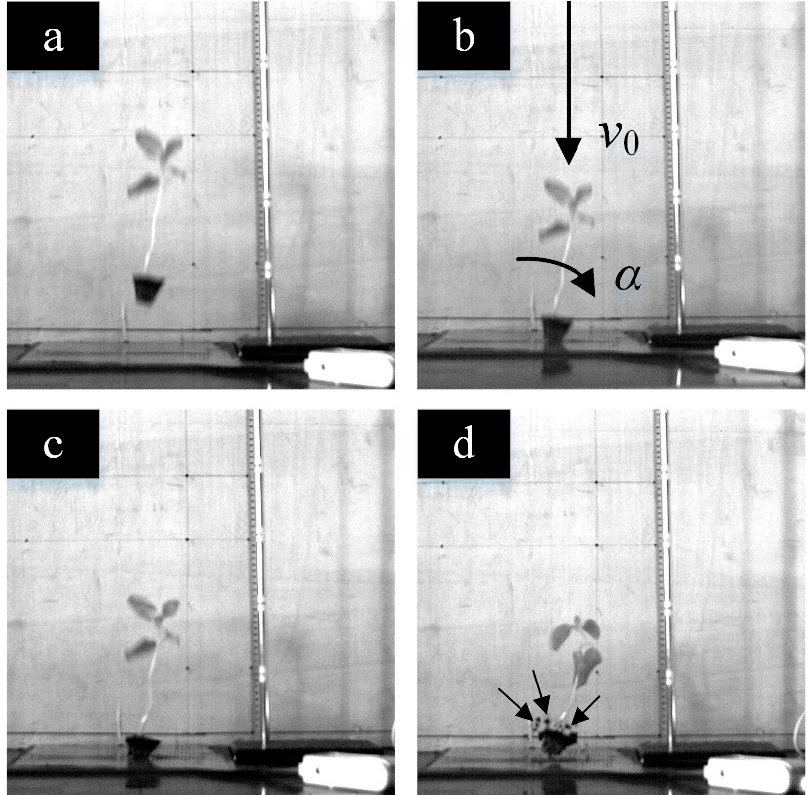
Figure 5. High-speed images of seedling collision: ( a – d ) represent the free drop, collision contact, collision compression, and rebound to the highest position of plug seedlings, respectively; α represents the rotation angle, defined as the angle between the stem and v 0 velocity direction, ( ◦ ). The collision material is steel plate, the drop height is 250 mm, and the seedling pot size is medium.